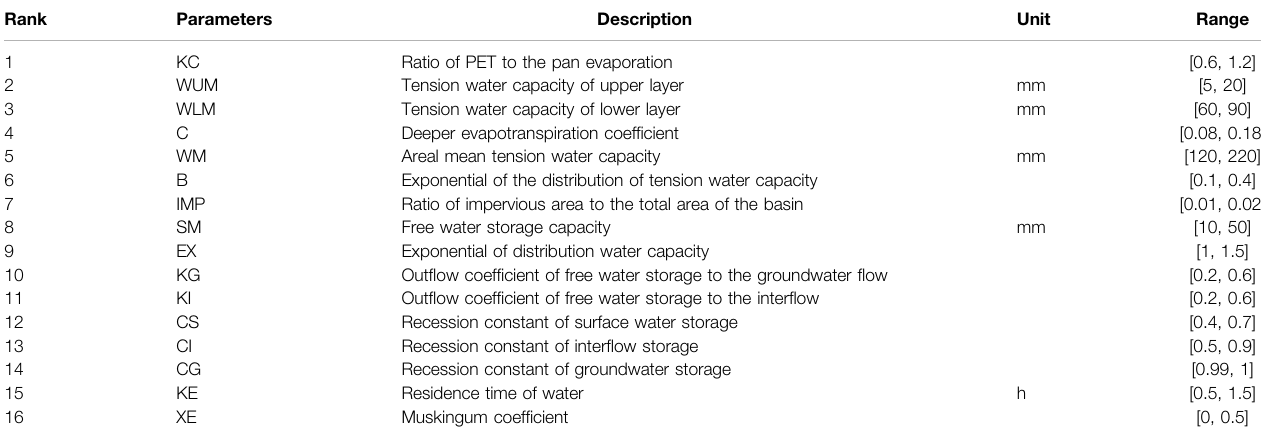
TABLE 2 | Parameters of XAJ